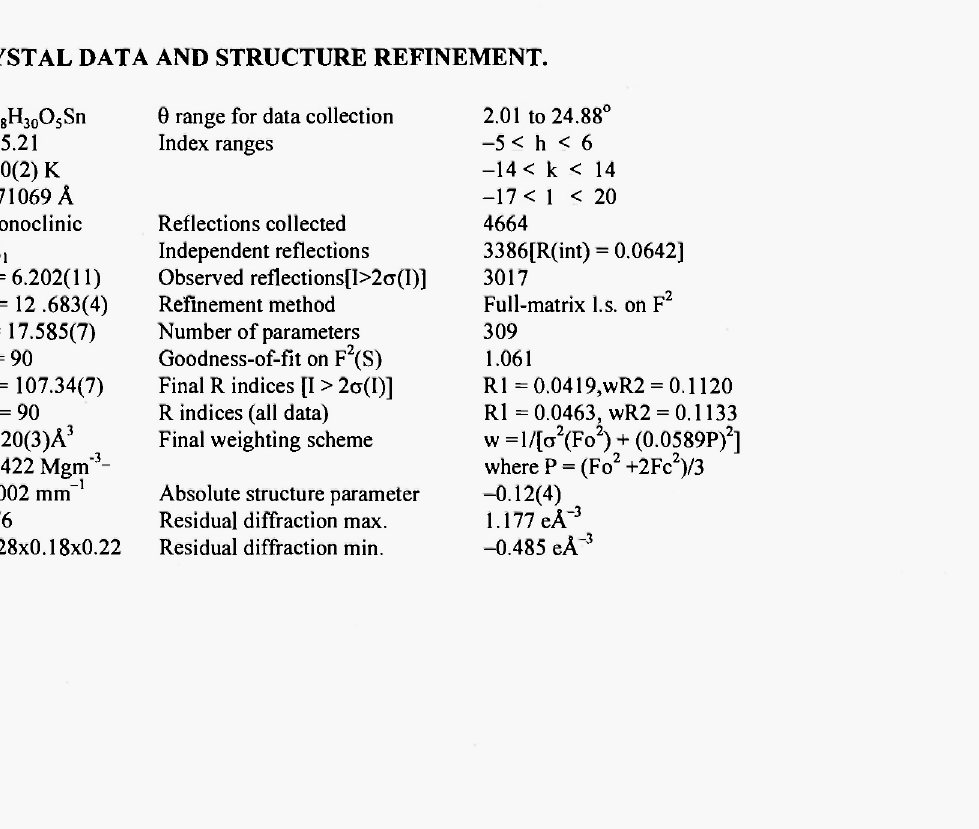
CRYSTAL DATA AND STRUCTURE